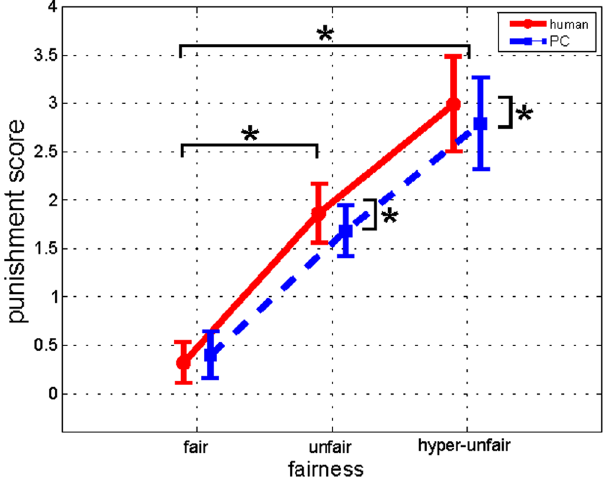
Figure 3. Analysis of behavioral data. Results of two-way repeated measures ANOVA considering punishment score as the dependent variable and AGENCY (human, PC) and FAIRNESS (fair, unfair, hyperunfair) as the main within-group factors (F = 4.37, p = 0.019). The bars represent the 95% confidence interval. * Indicates statistical differences between the corresponding levels (Neumann-Keuls post hoc test, p <